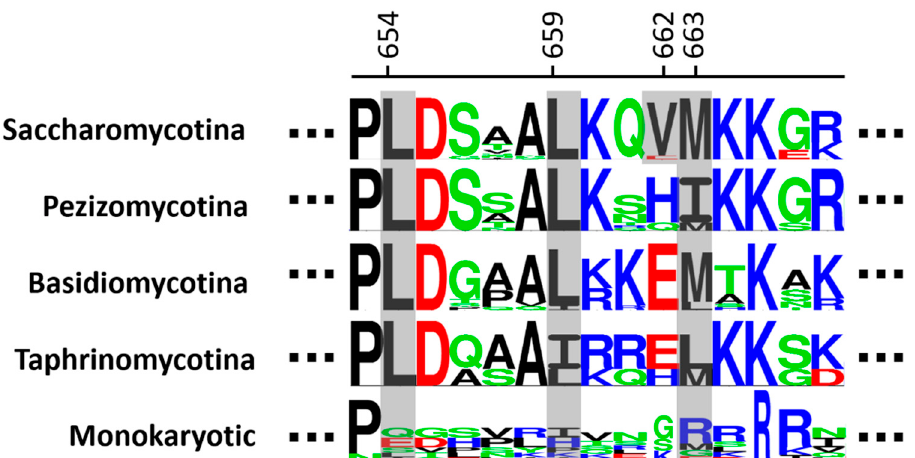
Figure 5. Conservation of the C-terminal extra alpha-helix in PPZ proteins. The abundance of specific residues at the C-terminus of PPZ proteins is depicted as logos grouping the different clades indicated on the left. Numbering corresponds to the S. cerevisiae Ppz1 enzyme. The residues discussed in the text are shaded in grey.